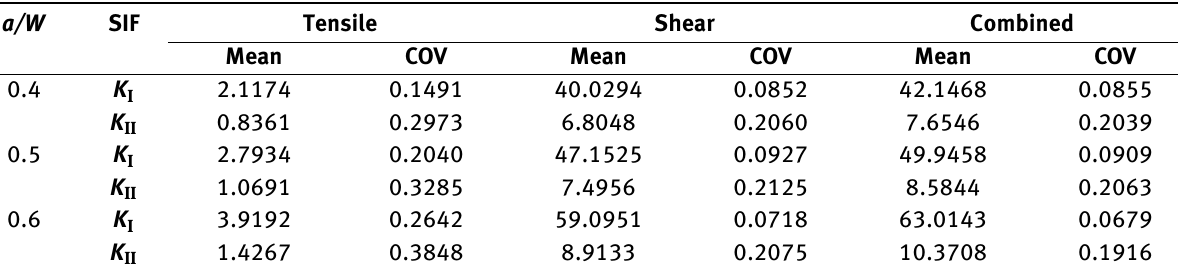
Table 5: Effect of a/W on the normalized mean and of K I and K II of double edge cracked FGMs plate subjected to uniaxial tensile, shear and combined stresses